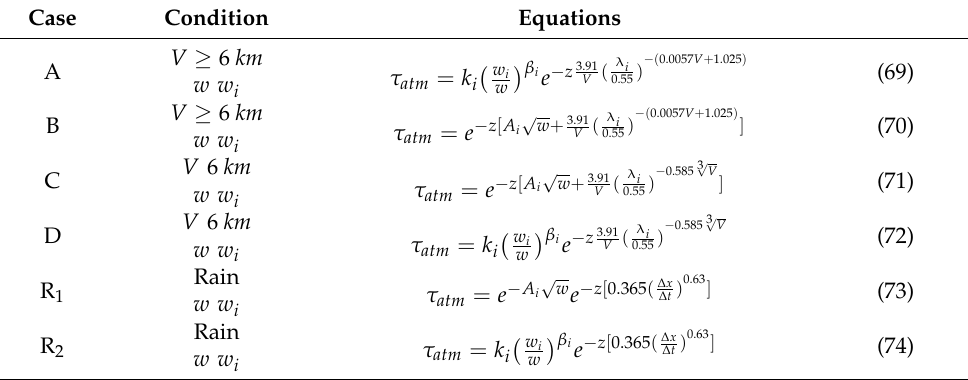
Table 13. Transmittance equations for collocated transmitter and receiver